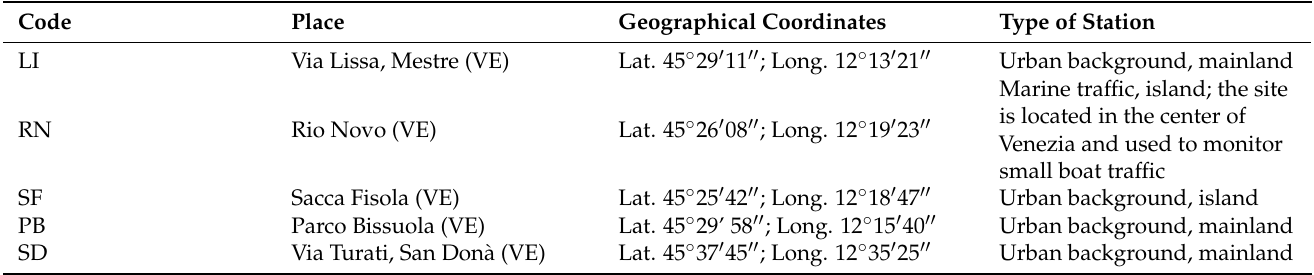
Table 2. Description of the sample